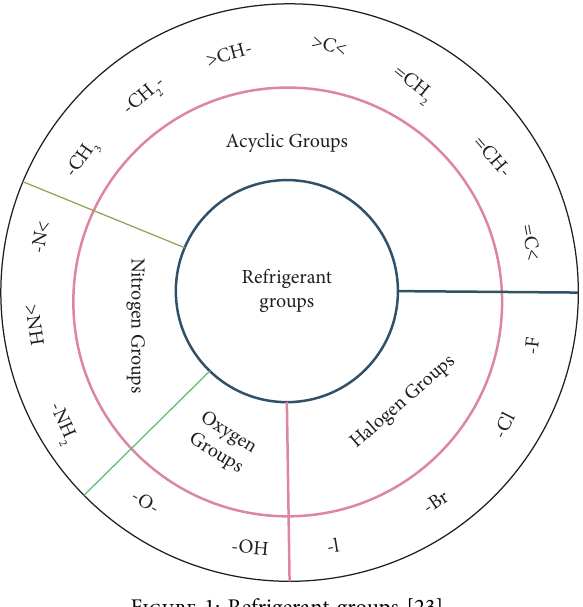
Figure 1: Refrigerant groups